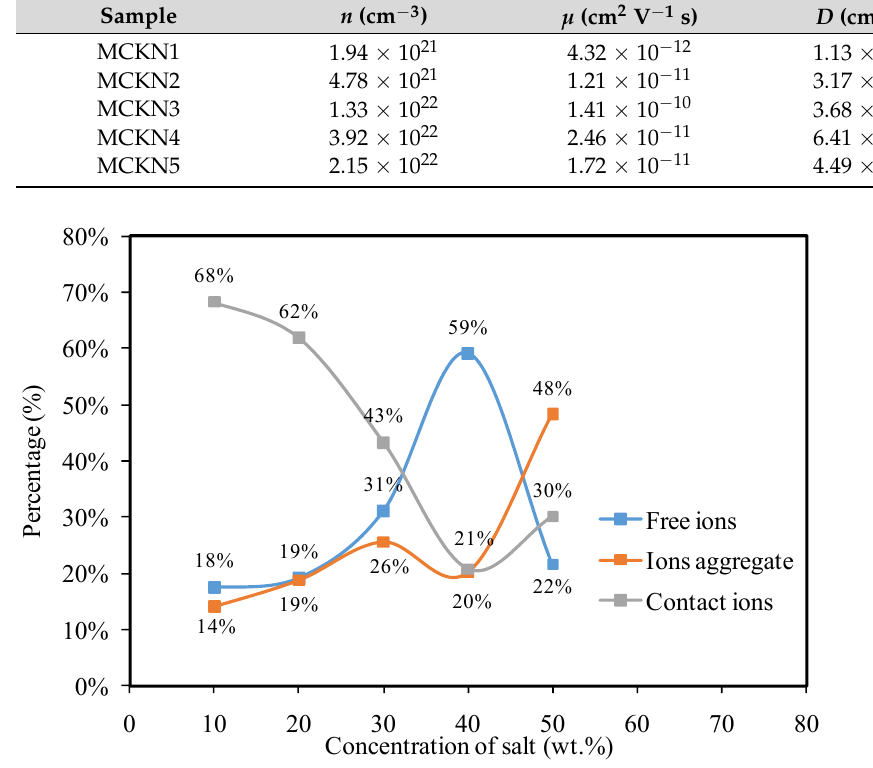
Figure 6. The percentage (%) of free ions, contact ions and ion aggregates vs. salt concentrations.